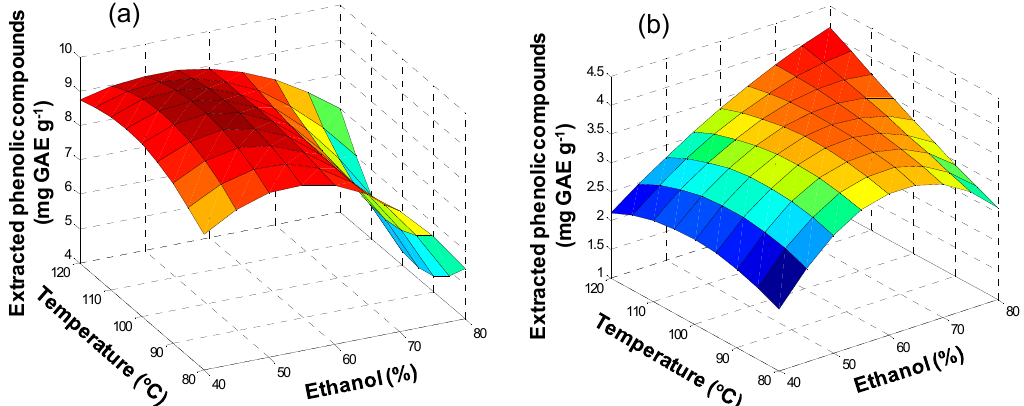
Figure 5. Response surface plots for extracted phenolic compounds (mg GAE g − 1 ) in ( a ) olive pomace and ( b ) lees filters by PLE as a function of ethanol concentration (%) and temperature (°C).